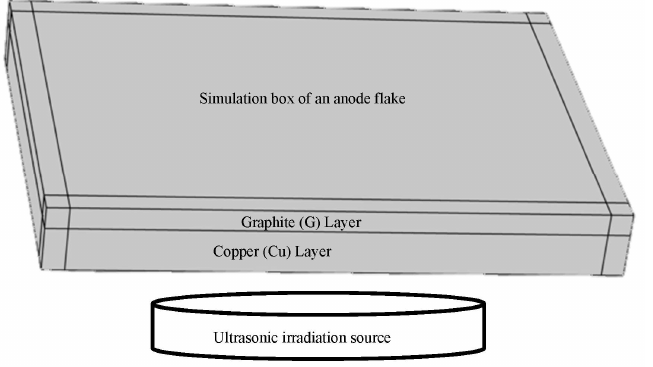
Figure 3. A piece of an anode electrode for qualitative simulation purposes.